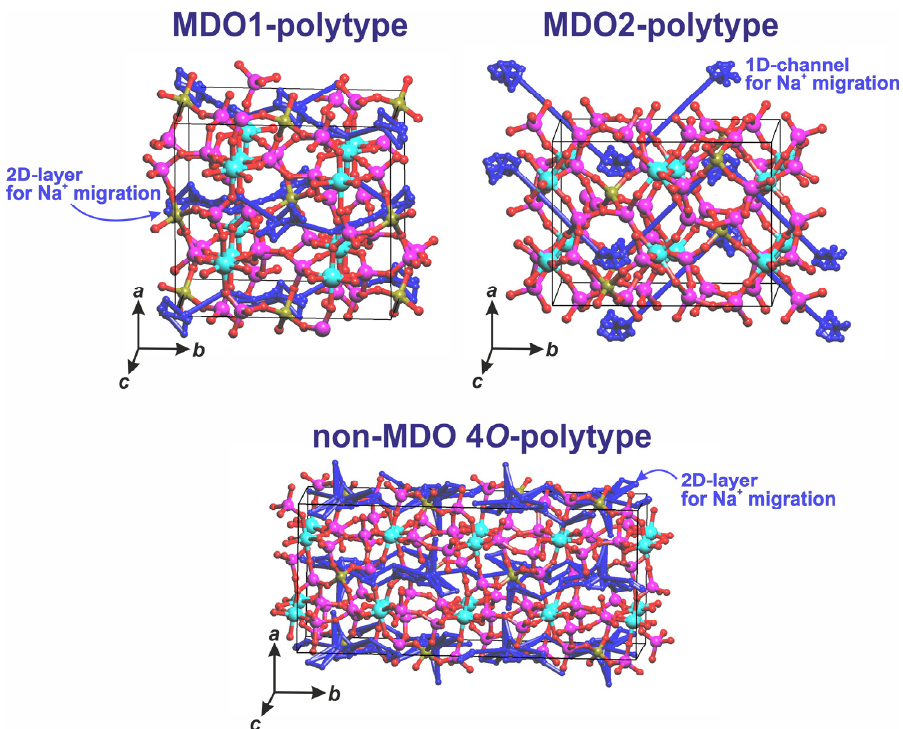
Figure 6. Possible ion migration path of Na + cations in the crystal structures of Cs{ [6] Al 2 [ [4] T P 6 O 20 ]} polytypes.